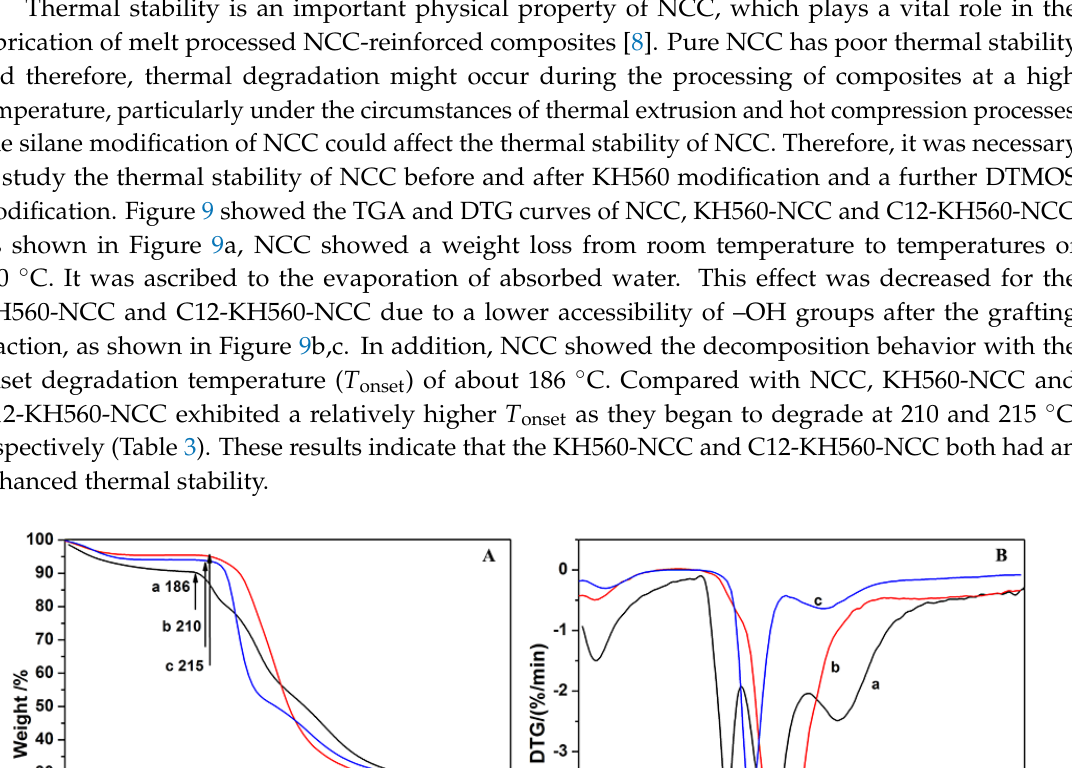
Figure 8. Effect of reaction time on the WCA of C12-KH560-NCC powders.